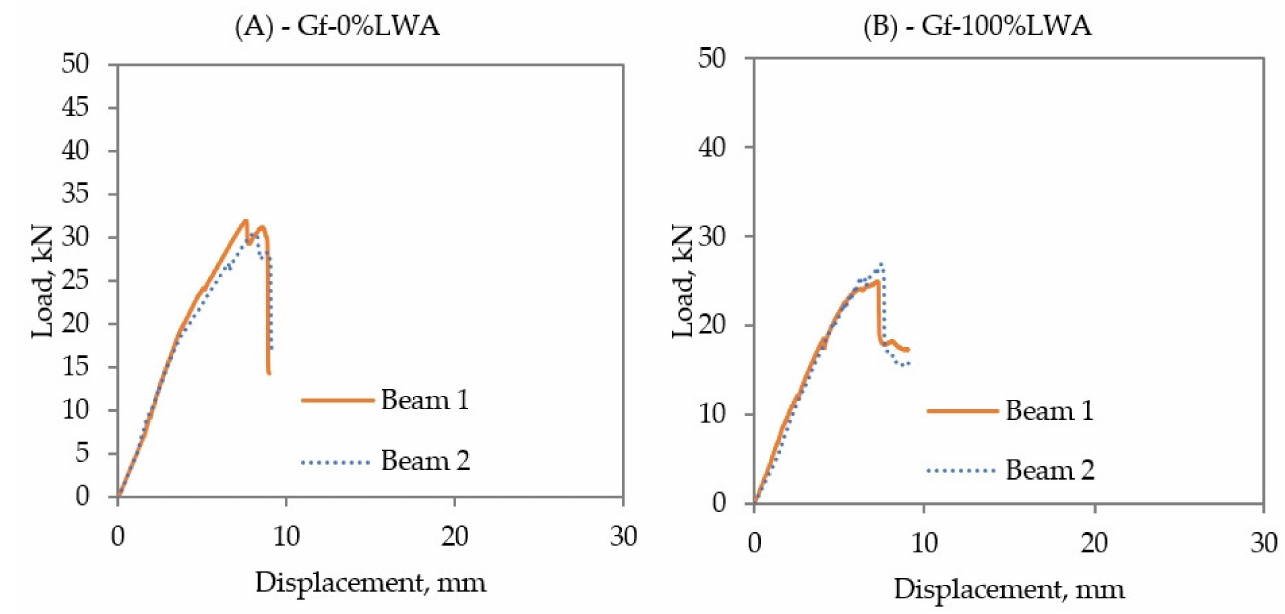
Figure 7. Load–displacement relationship of ( A ) Gf-0%LWA, and ( B ) Gf-100%LWA